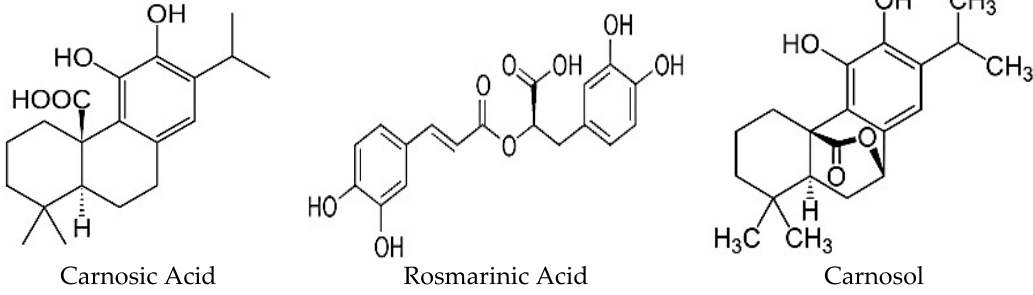
Figure 2. Structure of the major polyphenols of Rosmarinus officinalis : Carnosic acid, Rosmarinic acid and Carnosol.